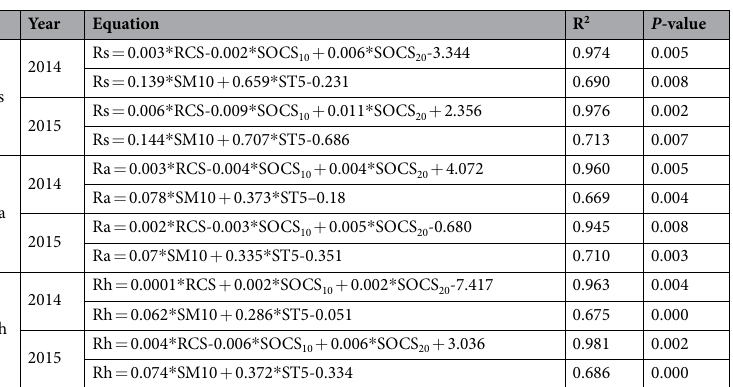
Table 2. Multiple linear regression equations of soil respiration (Rs), autotrophic respiration (Ra) and heterotrophic respiration (Rh) against root carbon storage (RCS), soil organic carbon storage in 0–10 cm layer (SOCS 10 ), soil organic carbon storage in 10–20 cm layer (SOCS 20 ), volumetric soil moisture at 10 cm depth (SM10) and soil temperature at 5 cm depth